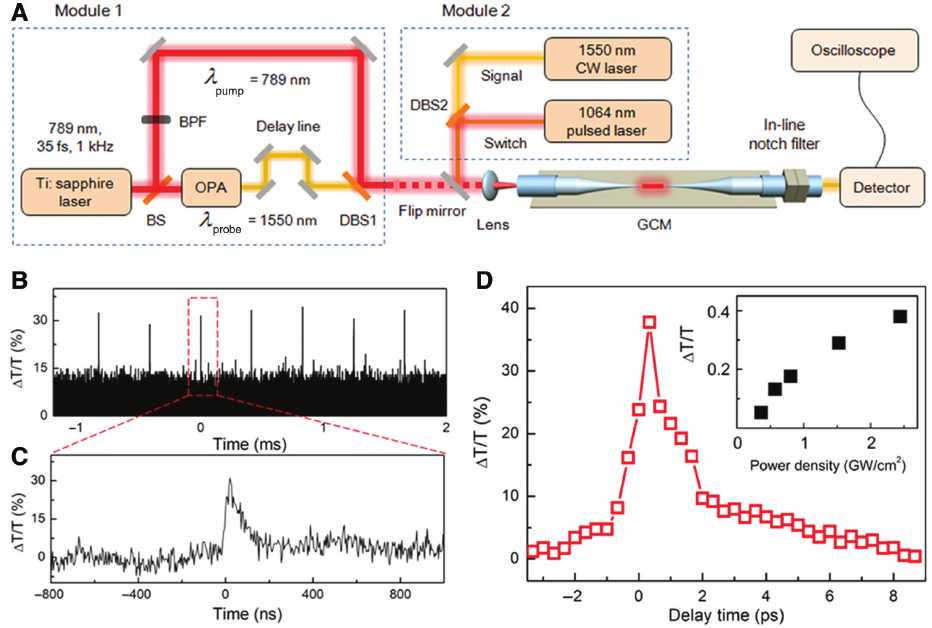
Figure 13: All-optical, all-fiber graphene modulator based on GCM. (A) Schematic illustration of all-optical modulation setups. (B) Pulses switched out from a 1550 nm CW beam in a GCM by a 5 ns 1064 nm pump pulse train. The induced differential transmittance is ~ 30%. (C) Time profile of a switched-out pulse. (D) Differential transmittance of the probe light through a 1.4 μ m GCM with 20 μ m long graphene cladding as a function of the pump-probe time delay with a pump power of 200 nW, showing a response time of ~ 2.2 ps. The inset shows the dependence of the modulation depth on pump intensity. Reproduced with permission [130]. Copyright 2014 American Chemical